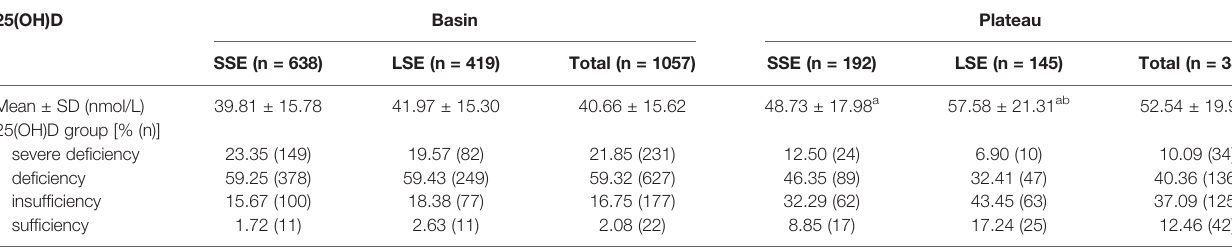
TABLE 2 | Distribution of 25(OH)D categorized by region and sunlight